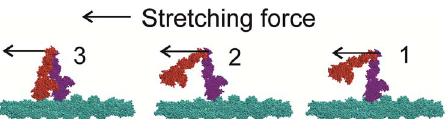
Figure 7. Schematic model of the movement of myosin heads upon muscle stretch that explains our data. During isometric contraction (state 1) only one (purple) head of a majority of myosin molecules is stereo-specifically bound to actin (cyan). Stretch unlocks the bound head to a non-stereo-specifically attached state and brings the distal part of the partner head to a position from which is can easily bind to a neighbor actin monomer (state 2). Then the second (red) head quickly binds actin also non-stereo-specifically (state 3). As both heads are bound non-stereo-specifically, the A1 intensity is low and stiffness is high. Further stretch leads to detachment of the purple head followed by its rapid rebinding to an actin 5.5 nm closer to the M-line of a sarcomere, thus producing a ‘head over head’ walking. The M-line of the sarcomere is on the left and the Z-disk is on the right.